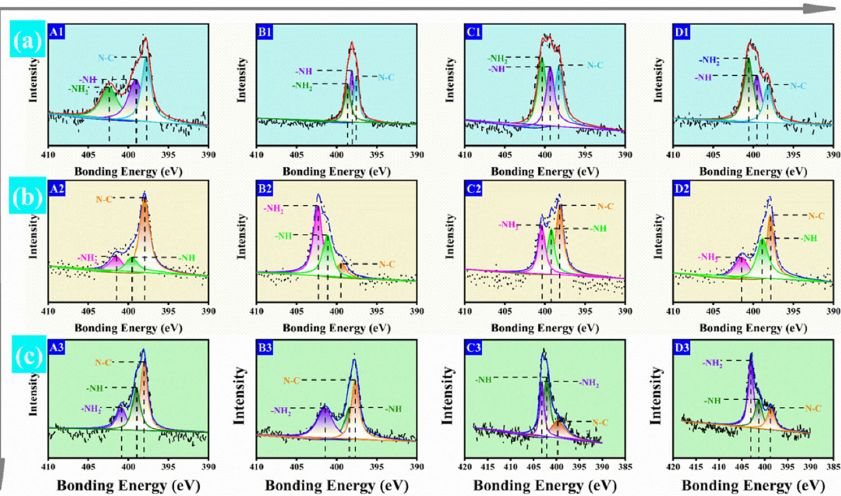
Figure 5. N 1s core ‐ level spectra of ( a ) A1 ‐ pure HPMP, B1 ‐ SDS/HPMP, C1 ‐ SDS/nSiO 2 /HPMP, and D1 ‐ HPMP adhesives. ( b ) A2 ‐ pure SBMP, B2 ‐ SDS/SBMP, C2 ‐ SDS/nSiO 2 /SBMP, and D2 ‐ SBMP adhe ‐ sives. ( c ) A3 ‐ pure CSMP, B3 ‐ SDS/CSMP, C3 ‐ SDS/nSiO 2 /CSMP, and D3 ‐ CSMP adhesives.